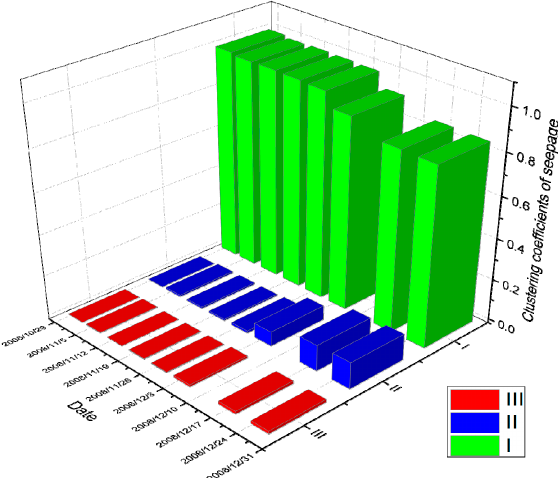
Figure 9. |𝑦 (cid:3047) − 𝑦(cid:3548) (cid:3047) |/𝑆 and the clustering coefficient of each seepage indicator. Figure 9.